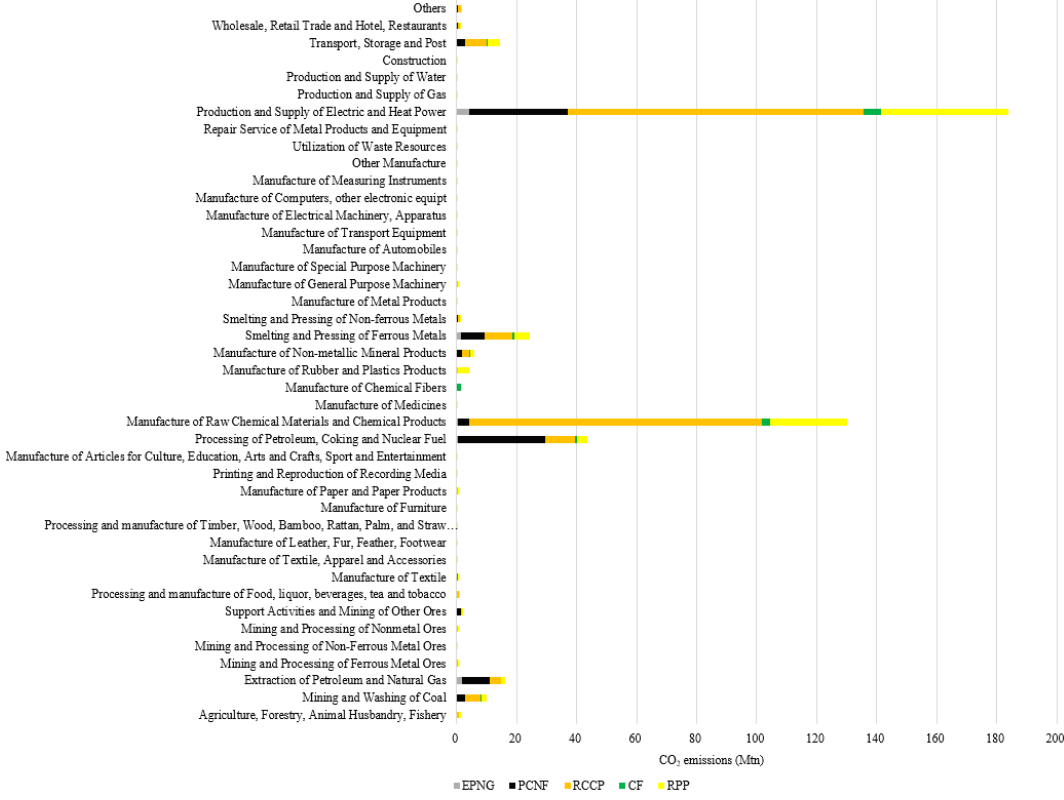
Figure 5. Contribution of sectors to indirect CO 2 emissions of the petrochemical industry (2012).